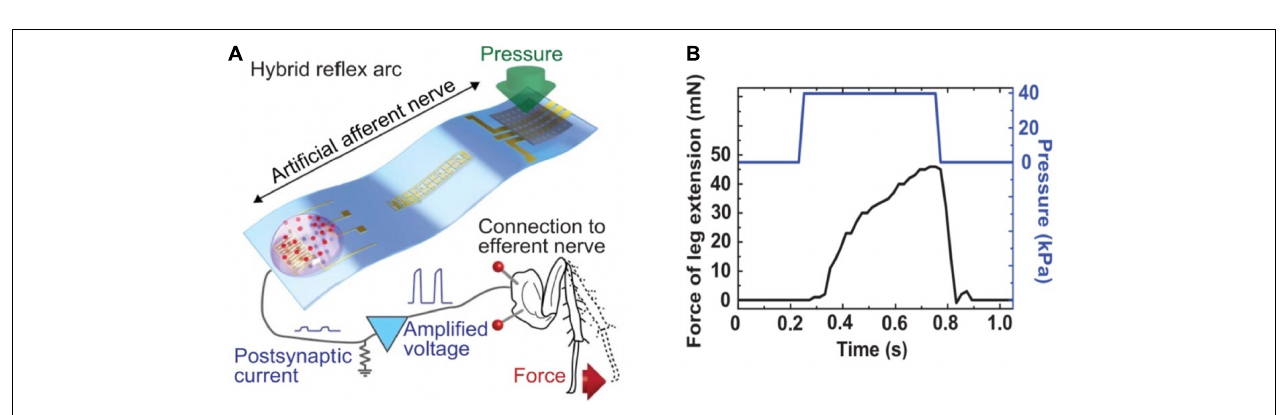
FIGURE 20 | (A) Schematic diagram of the hybrid reflex. (B) Force measured from the tibial extensor muscle when pressure is applied on the hybrid reflex arc (adapted from Kim et al.,